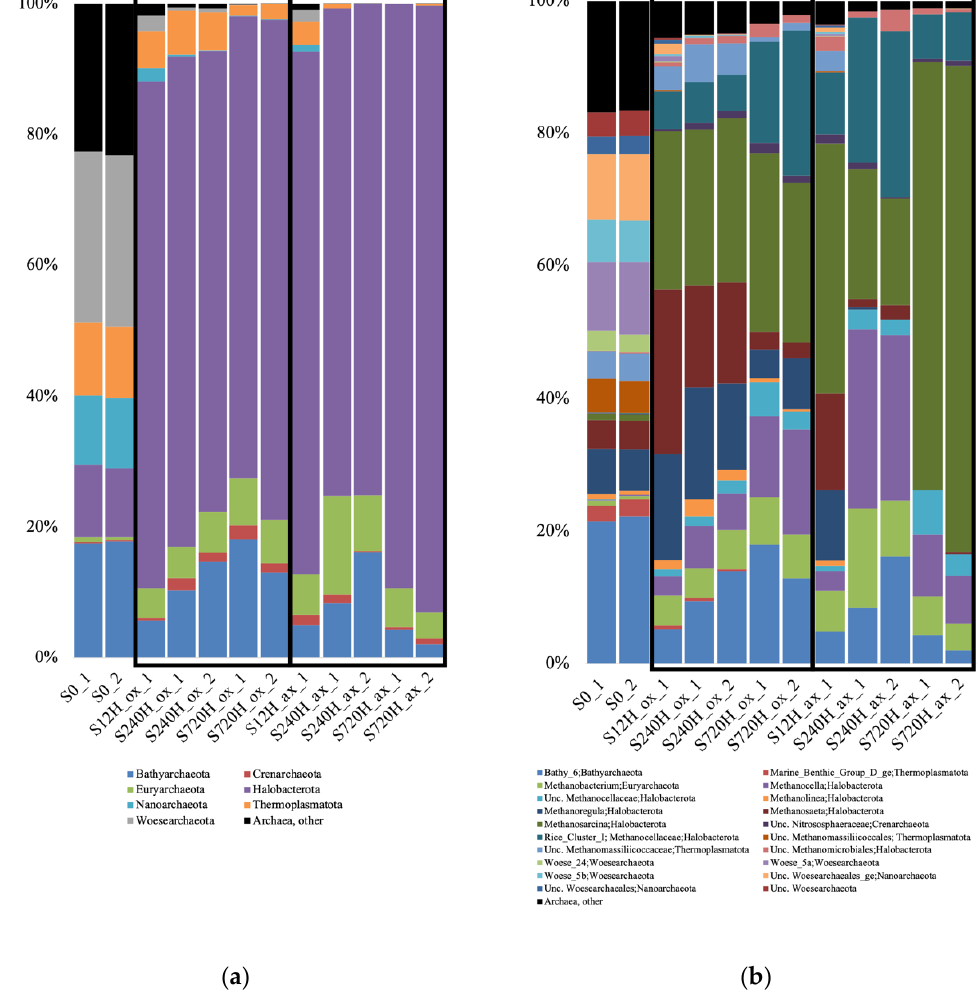
Figure 4. Relative abundance of the archaeal taxonomic groups at the phylum ( a ); and genus ( b ) levels, in the oxic (ox) and anoxic (ax) incubations, in the sediment (S) samples, and for both duplicates (_1 and _2). Relative abundance is expressed in percentage of the total number of sequences for each sample. S0, initial sediment before incubation; Unc, unclassified.